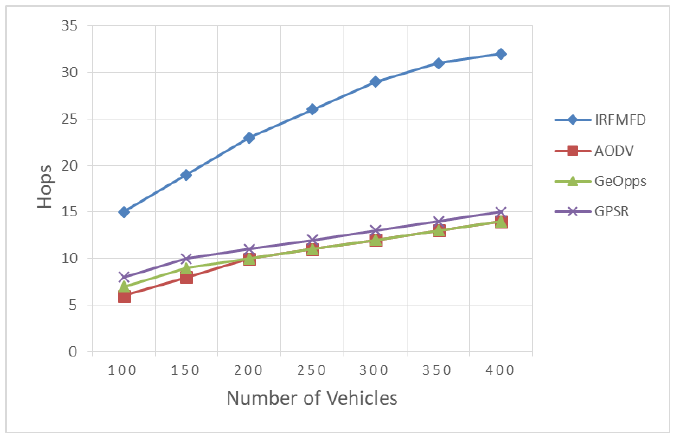
Figure 9. Average hop count with different number of vehicles .